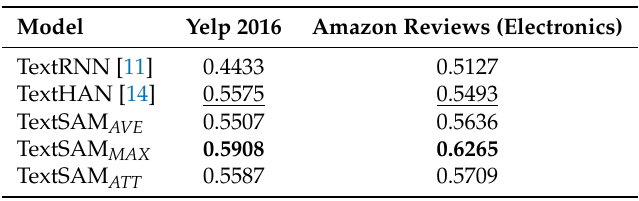
Table 3. Accuracy on the document classification task in the holdout methods. The results of the best baseline and the best performer in each column are underlined and boldfaced,